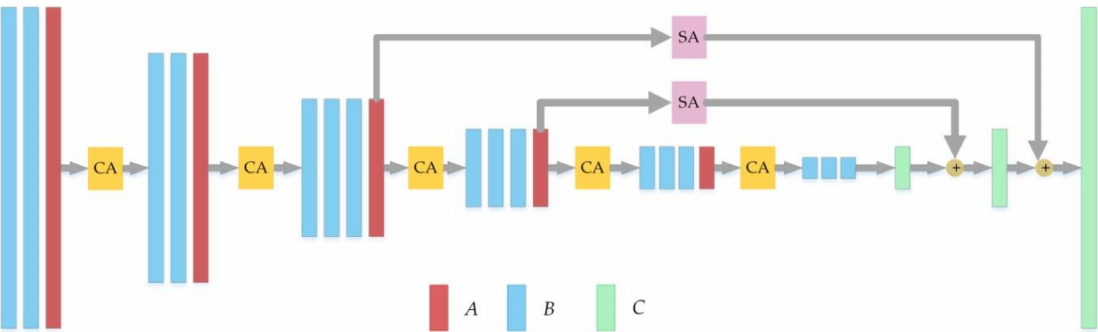
Figure 8. Architecture of FCN-8s-SCA. A is max pooling layer; B are convolutional + Rectified Linear Unit (ReLU) layers; C is the transpose convolutional layer; SA is the spatial attention mechanism; CA is the channel attention mechanism; RS is the reshape